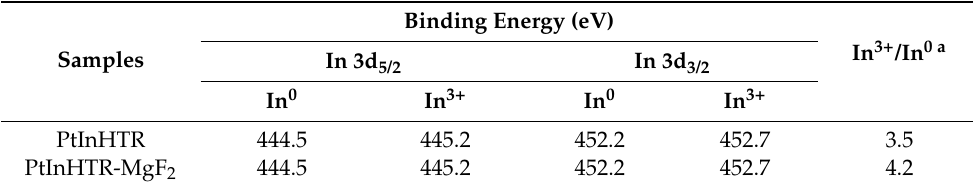
Table 1. XPS results of the In 3d regions for the reduced